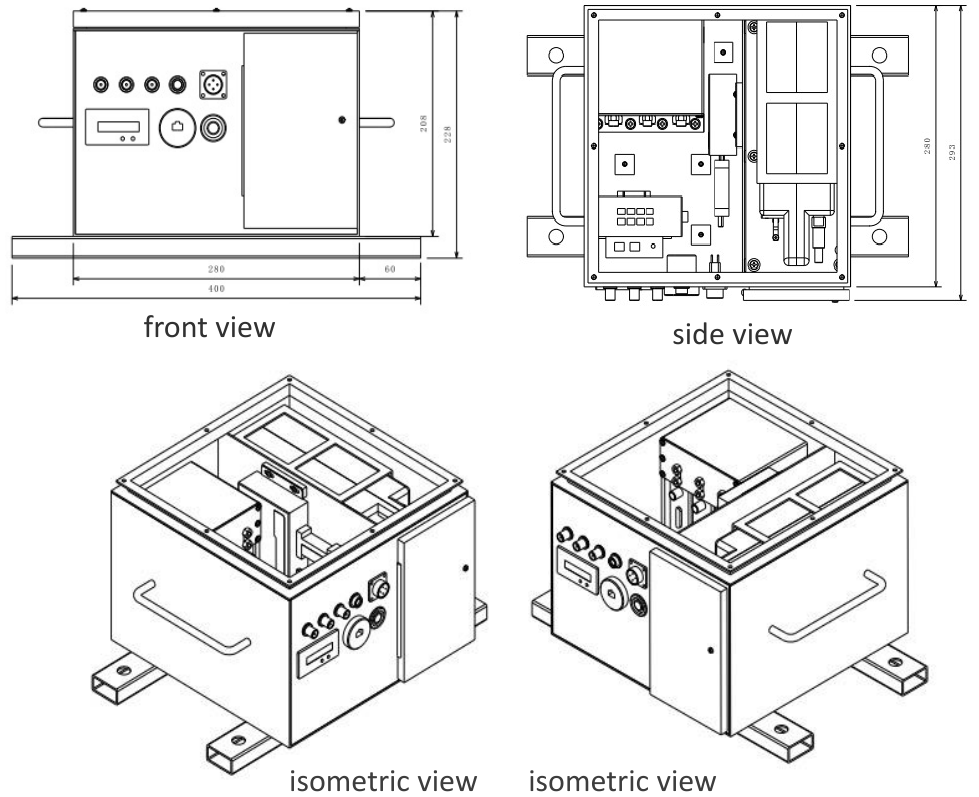
Figure 2. The mechanical design drawings of the GNSS antenna and static level integration equipment.